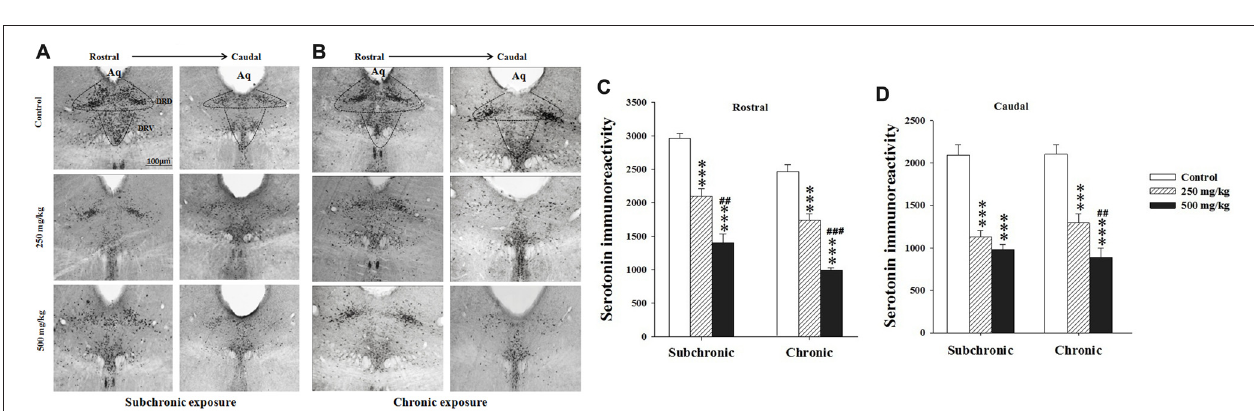
FIGURE 5 | Effect of subchronic and chronic exposure to GBH on dopaminergic neurons. (A) Photomicrographs of mice brain cross sections showing the tyrosine hydroxylase (TH)-immunoreactive neurons at the SNc. (B) The intensity of TH Immunoreactivity at the SNc in control and treated mice. SNc, substantia nigra pars compacta. Results are presented as mean ± SEM. ∗∗∗ P < 0.001. The ∗∗∗ refers to the control vs. 250 mg/kg and 500 mg/kg group comparison and the “#” refers to the 250 mg/kg vs. 500 mg/kg group comparison. ### P < 0.001: the post hoc analysis.